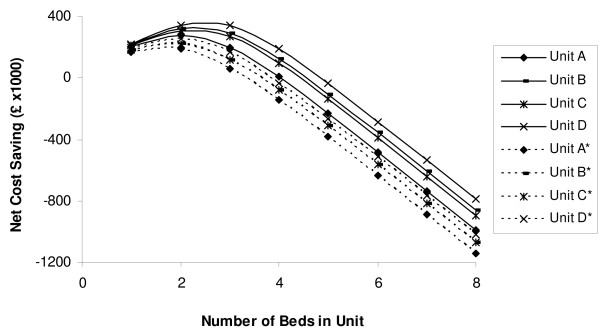
Net cost saving of establishing a weaning unit with differing bed capacities. *The broken lines represent the effect of unstable patients being transferred out of the weaning unit back to the ICU.